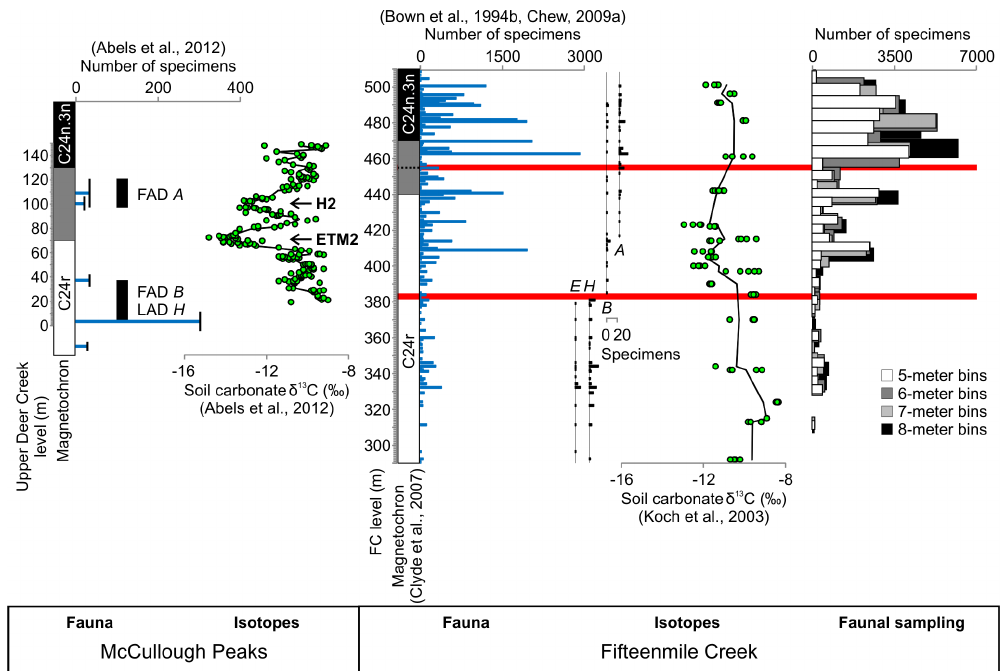
Figure 2. Available fossil samples and carbon isotope data from the northern and south–central parts of the Bighorn Basin. Both the McCullough Peaks isotope sections (Abels et al., 2012) and this part of the Fifteenmile Creek (FC) section (Bown et al., 1994b) include distinctive biostratigraphic events: the first (FAD) and last (LAD) appearances of Bunophorus etsagicus ( B ), Haplomylus speirianus ( H ), Ectocion osbornianus ( E ) and Anacodon ursidens ( A ). The McCullough Peaks isotope sections and this part of the FC section also include the C24r–C24n.3n geomagnetic shift (gray shading indicates intervals of mixed polarity). The common occurrence of the biostratigraphic and geomagnetic events (indicated by thick, red lines for the FC section) indicates that this part of the FC section corresponds to the McCullough Peaks isotope sections. Previous isotope analysis of FC soil carbonates (Koch et al., 2003) was not sufficiently resolved to identify CIEs as in the McCullough Peaks, but those results do not preclude the possibility of CIEs in this part of the section. FC mammal fossils are binned into four series of overlapping, equal-length intervals for paleoecological